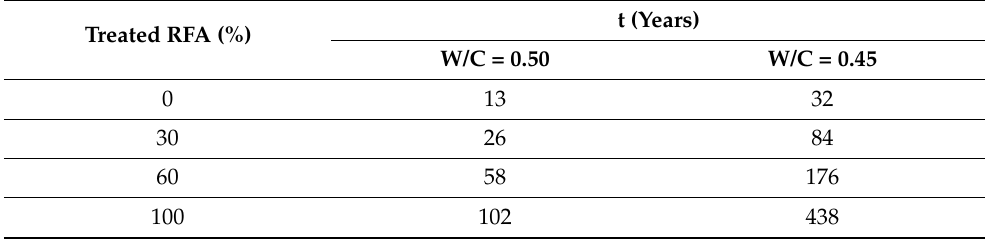
Table 6. Durability of mortar made with different replacement of treated RFA at 0.5 mol/L–7d–20 ◦ C.